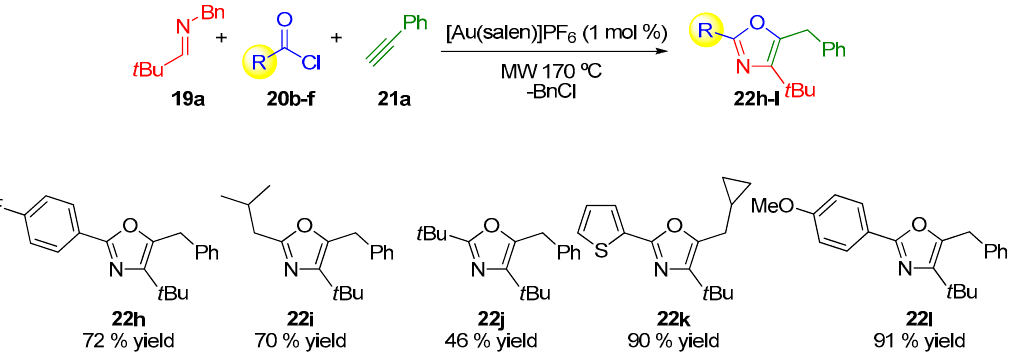
Scheme 7. Structural variations in the acyl chlorides 20 .